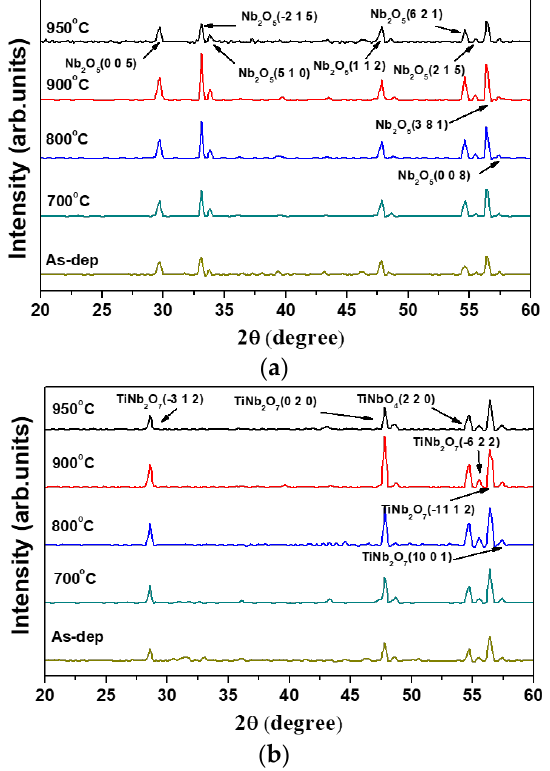
Figure 5. XRD spectra of the ( a ) Nb 2 O 5 and ( b ) TiNb 2 O 7 films.